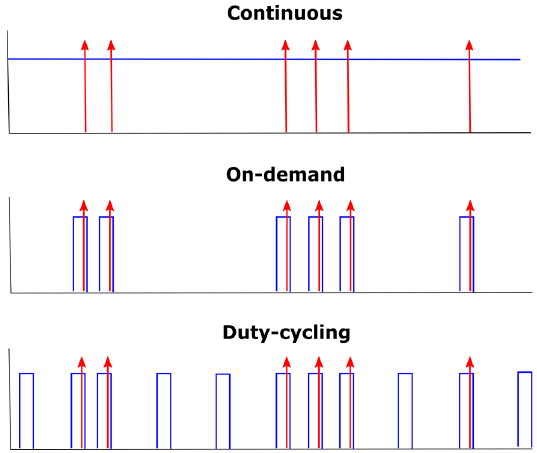
Figure 4. Schematic illustration of the three power management strategies used in this work. The blue solid lines represent the heater voltage and the red arrows indicate when the measurements are taken.